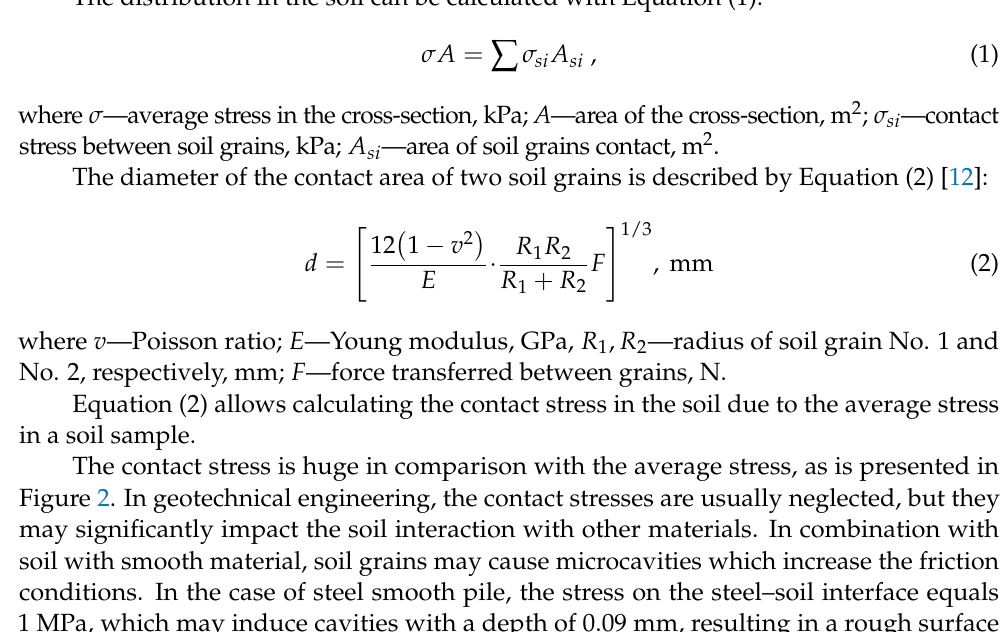
Figure 1. Stress distribution in soil. ( a ) Real distribution; ( b ) equivalent distribution.